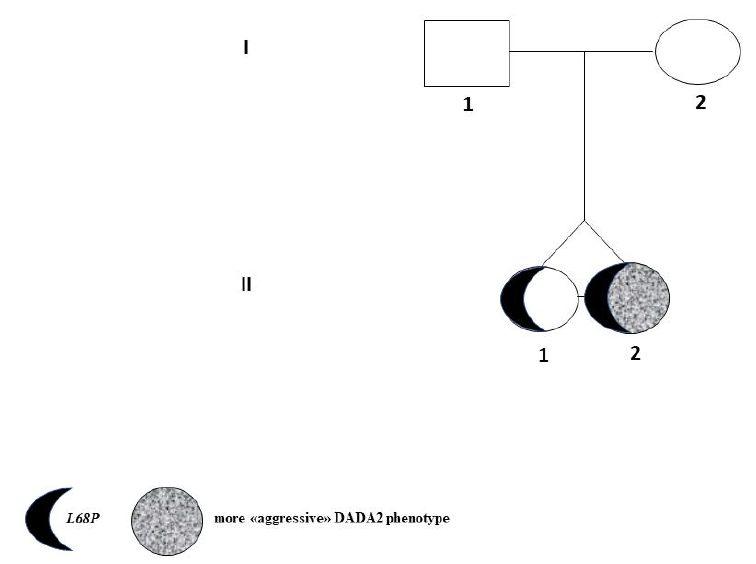
Figure 2. Pedigree of family ADA2-AUXMI1. Table 1. Chronological order of bone unrelated abnormalities occurrence [( A ): II-1 Tw1. ( B ):